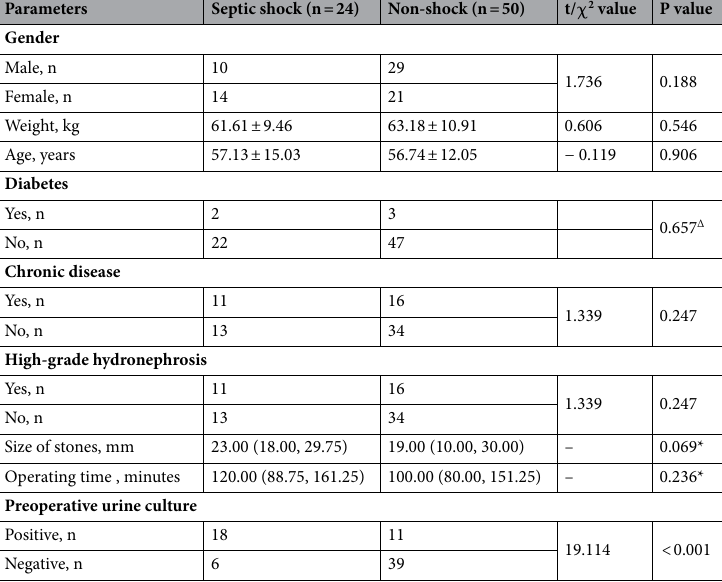
Table 3. Univariate analysis results of preoperative risk factors about the patients with postoperative infection progressed to septic shock. Δ The result was obtained using Fisher’s exact probability test. *The result was obtained using the rank-sum